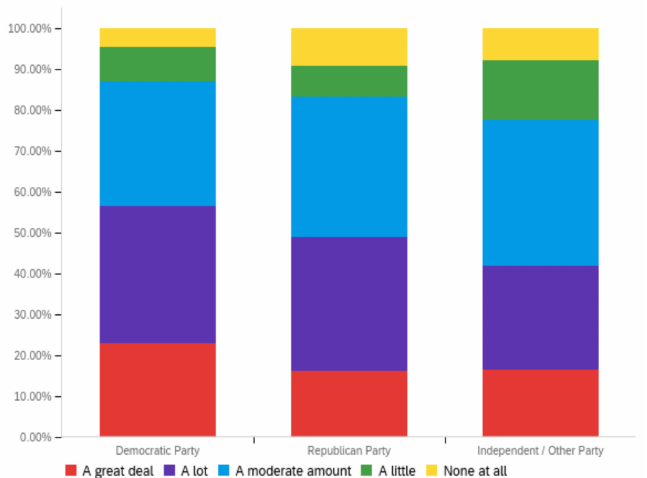
Figure 2. Article author—others’ perception impact by political